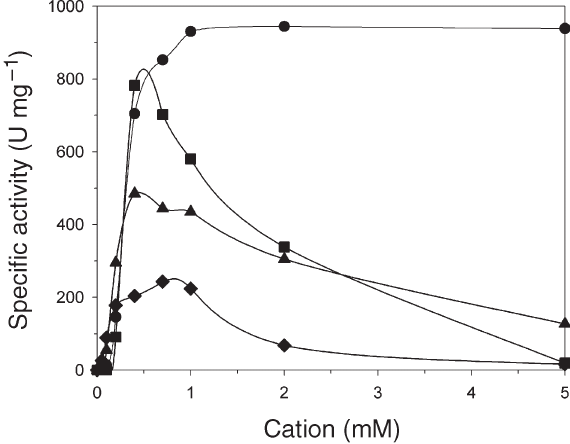
Figure 3. Effect of divalent cation concentration on pyrophosphate (PP i ) hydrolysis. Assay conditions were as follows: 50mM Tris-HCl, pH 7.5, 1 mM sodium pyrophosphate (NaPP i ), and concentrations of divalent cations were varied as indicated. Symbols: (cid:3) = Mg 2+ ; (cid:5) = Zn 2+ ; (cid:6) = Co 2+ ; and (cid:7) = Mn 2+ .